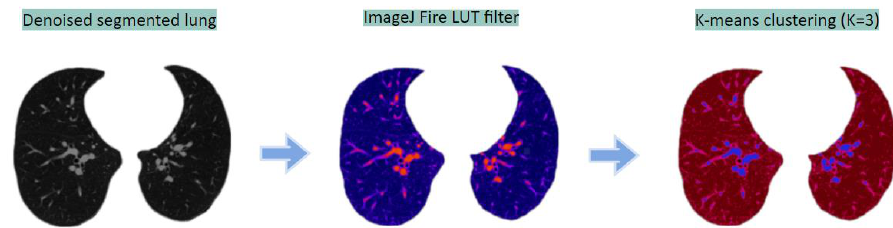
Figure 23. Segmentation of BA from the lung portions using clustering approach. Some outputs achieved from this approach are shown in Figure 24.